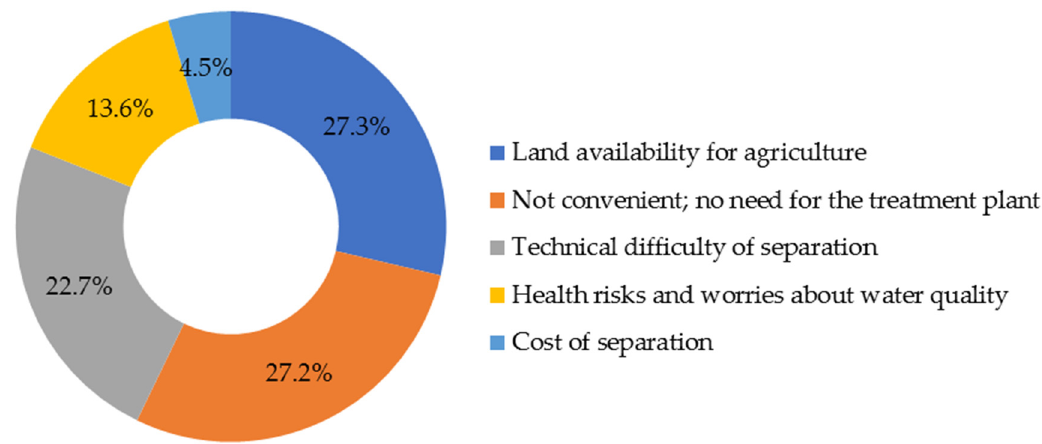
Figure 8. Reasons for non-acceptance of house internal sewage pipes separation.